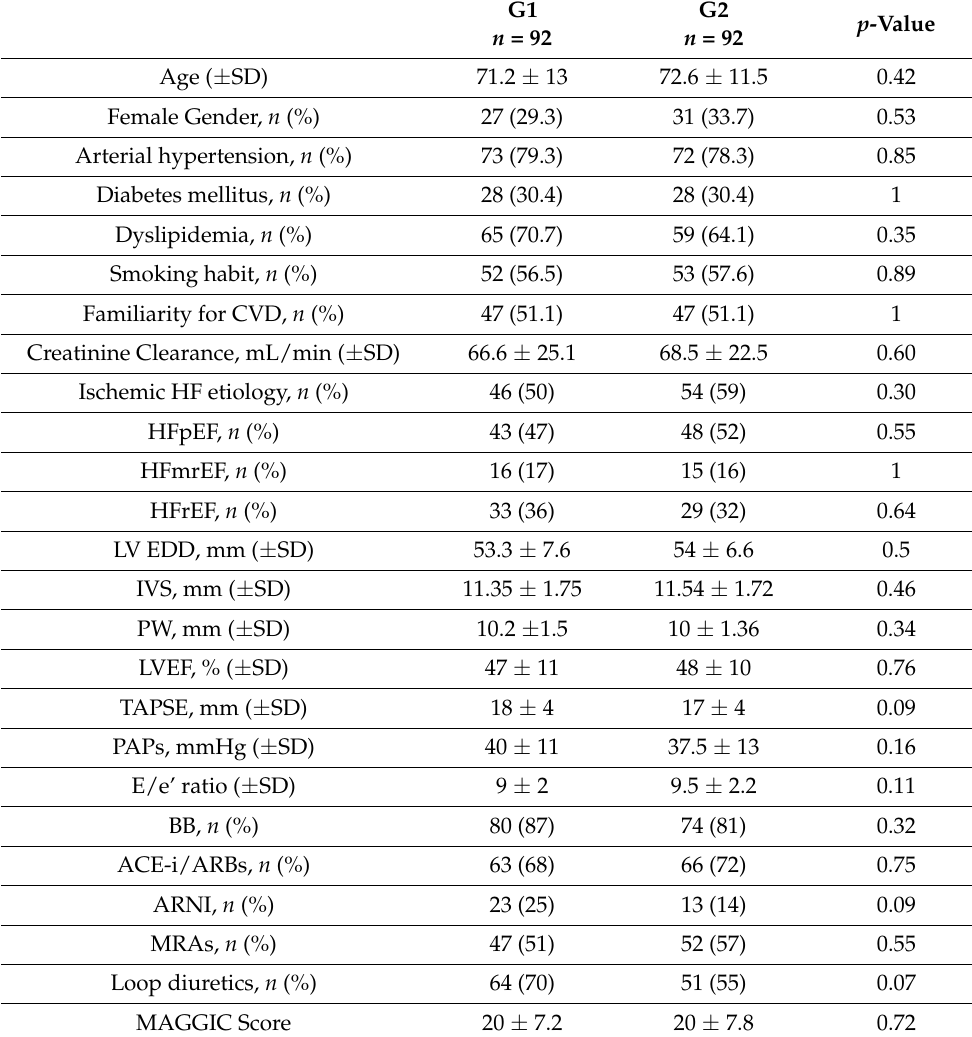
Table 2. Baseline characteristics after propensity matching score